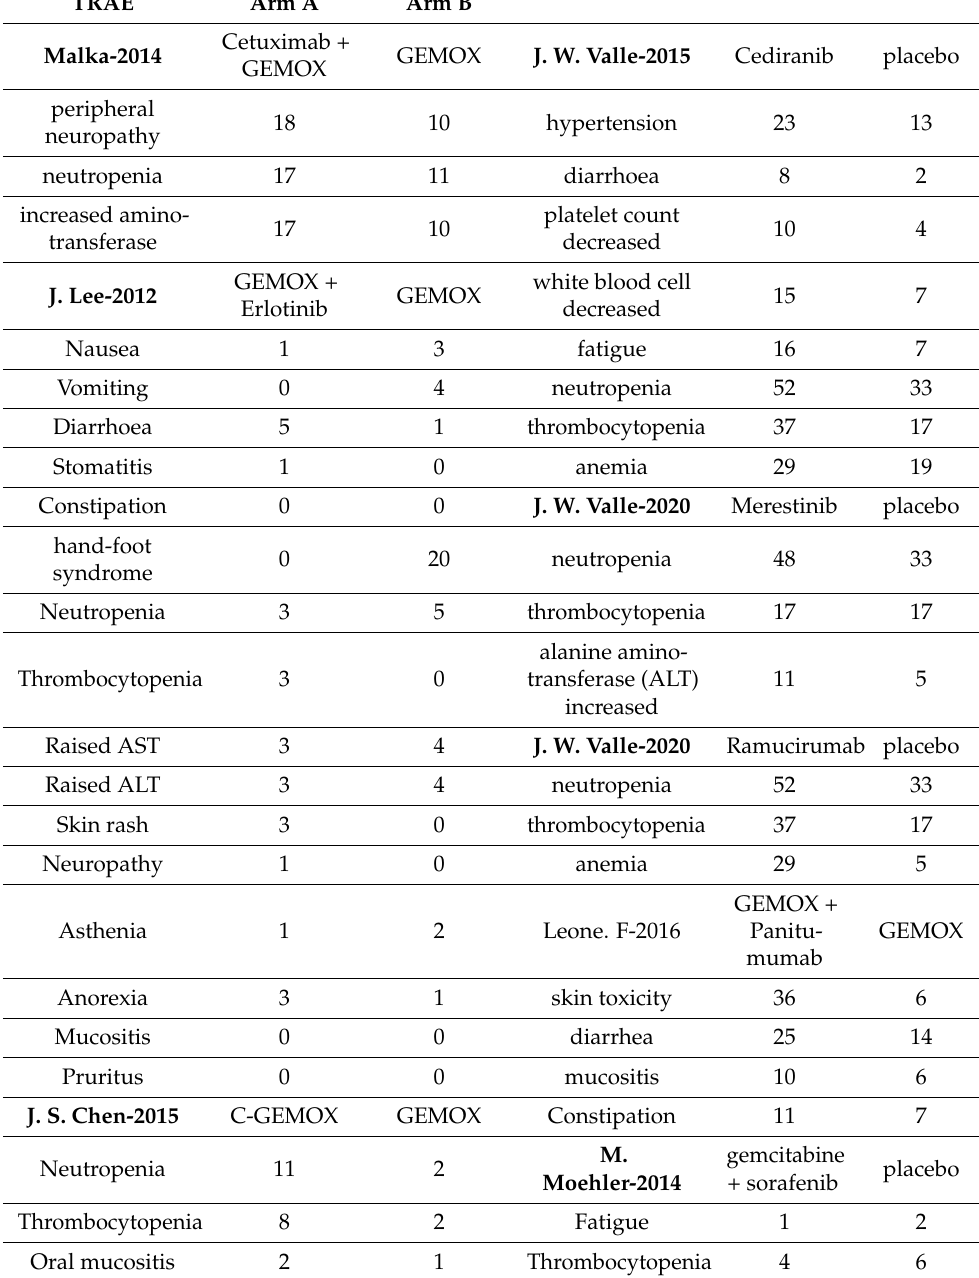
Table 7. Treatment-Related Adverse Events of targeted